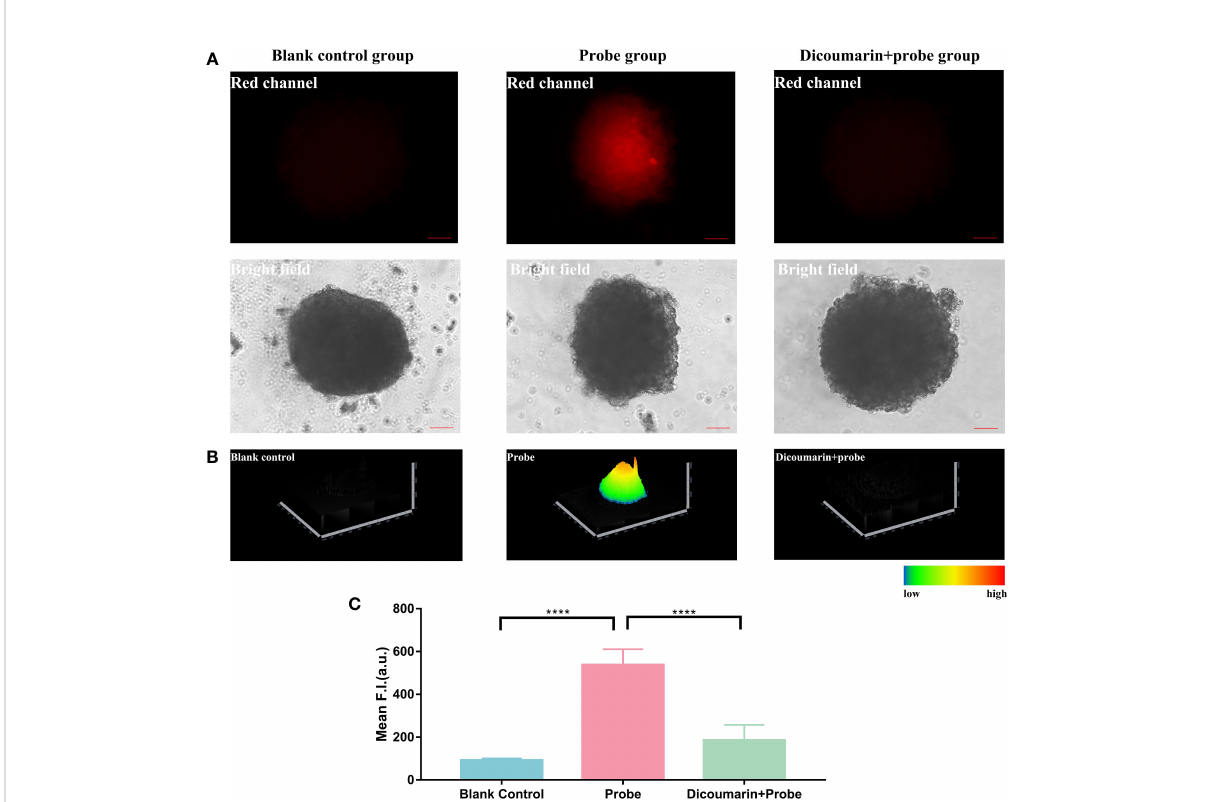
FIGURE 4 (A) Fluorescence imaging of 3D hemagioma microspheres. Blank control group was treated with pure ECM to reduce the auto fl uorescence of the microspheres; Probe group was treated with only HNT-NTR; Dcioumarin group was prestreated with dicoumarin and then incubated in HNT-NTR to inhibit NTR. (B) 2.5D heatmaps of the fl uorescence signal. The strongest fl uorescence signal could be found in the core of 3D microsphere, in contrast with the weaker signal in the surrounding area. (C) Quantitative analysis on the fl uorescence intensity of each group. Signi fi cant difference could be found between the probe group and the dicoumarin blockage group, indicating the successful development of hemangioma 3D model and demonstrating that HNT-NTR could monitor hypoxia condition in 3D microsphere with the response to NTR. Scale bar= 100 m m. ****P ≤